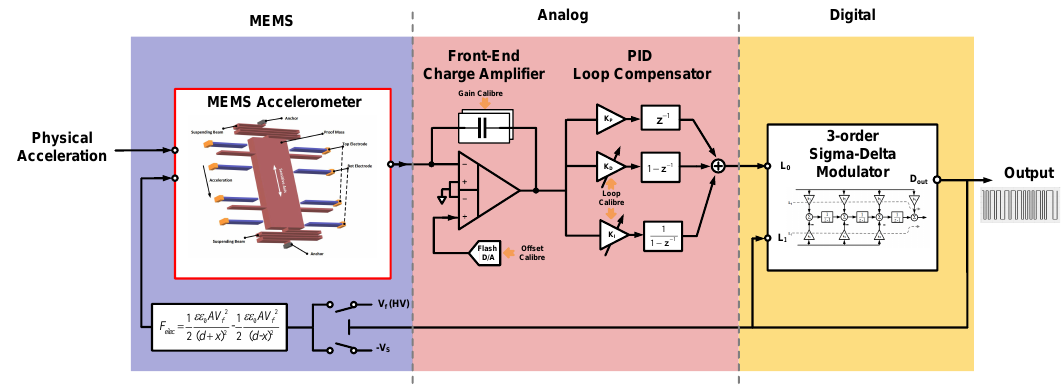
Figure 1. The architecture of the EM- Σ∆